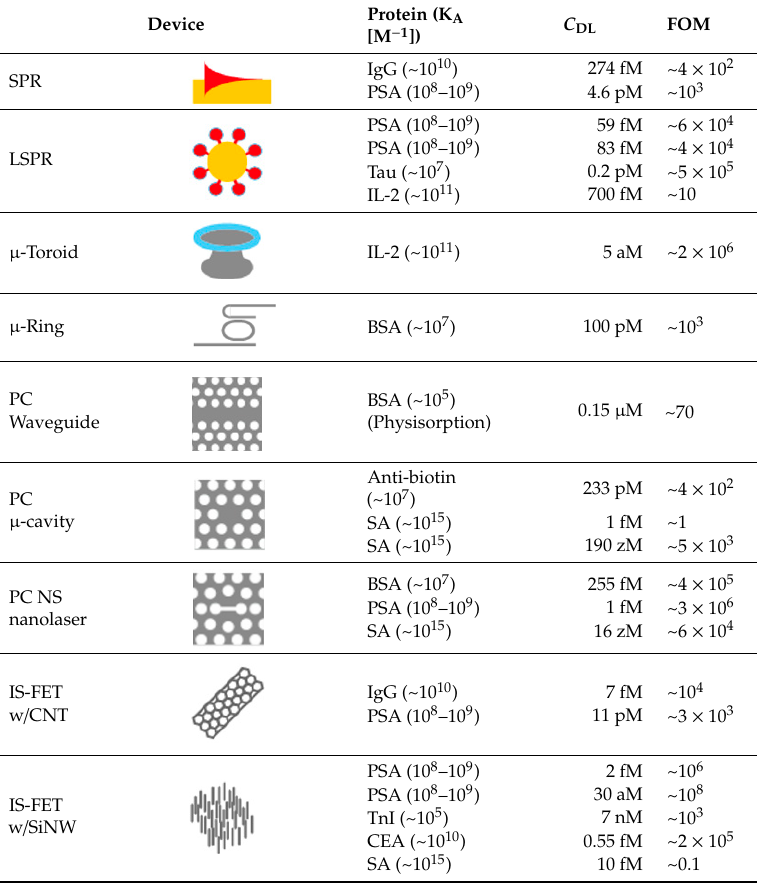
Table 1. Performance comparison of label-free photonic biosensors in references and the electronics biosensor . SPR: surface plasmon resonance; LSPR: localized surface plasmon resonance; PC: